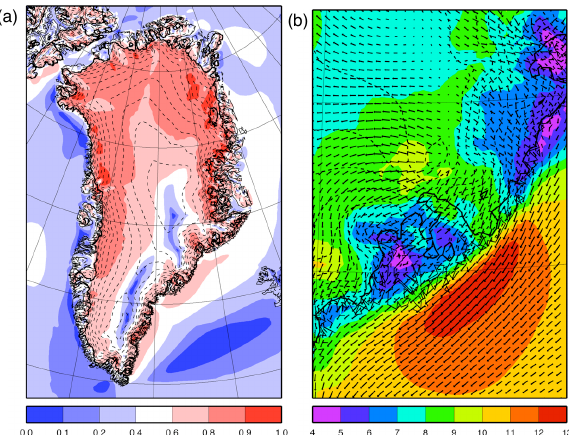
Fig. 3. (a) Directional constancy [ − ] based on annual wind speed and direction, and (b) DJF mean of 10m wind field (vectors [ms − 1 ]) and its magnitude (colouring [ms − 1 ]) plotted at full model resolution for the box indicated in Fig.